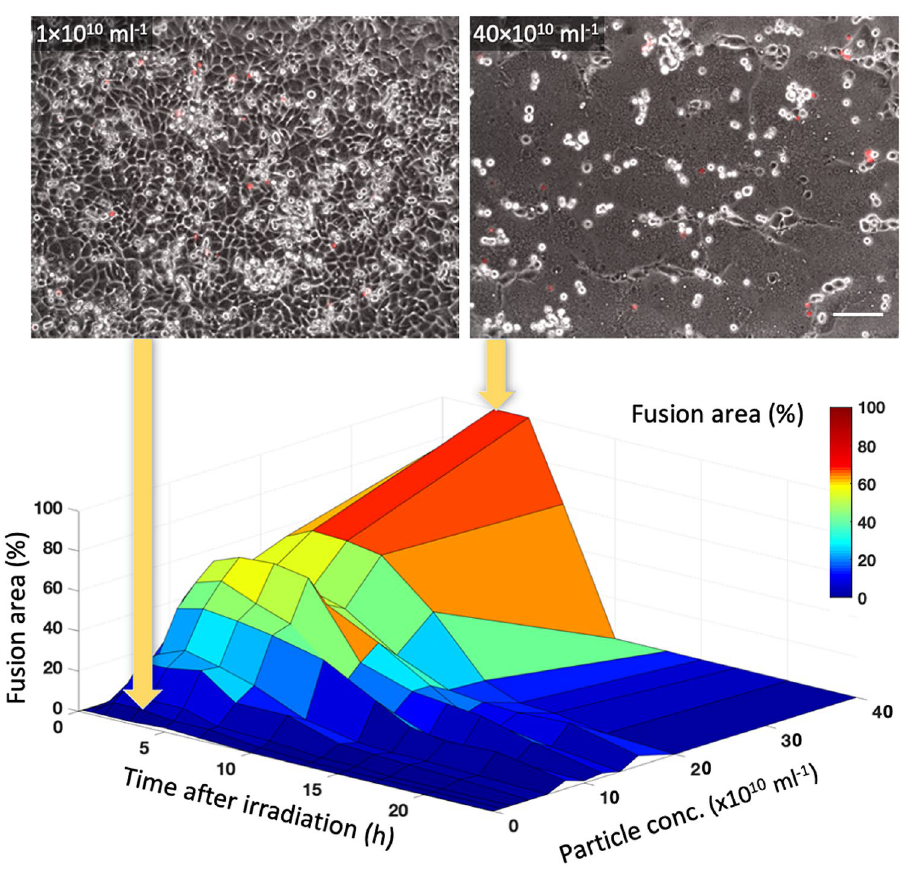
Figure 2. Progression of the relative fusion area for different particle concentrations. The top panels show the cell cultures for the two most extreme concentrations that were tested, 3 h after irradiation. Red stained cells correspond to necrotic cells. Scale bar represents 50